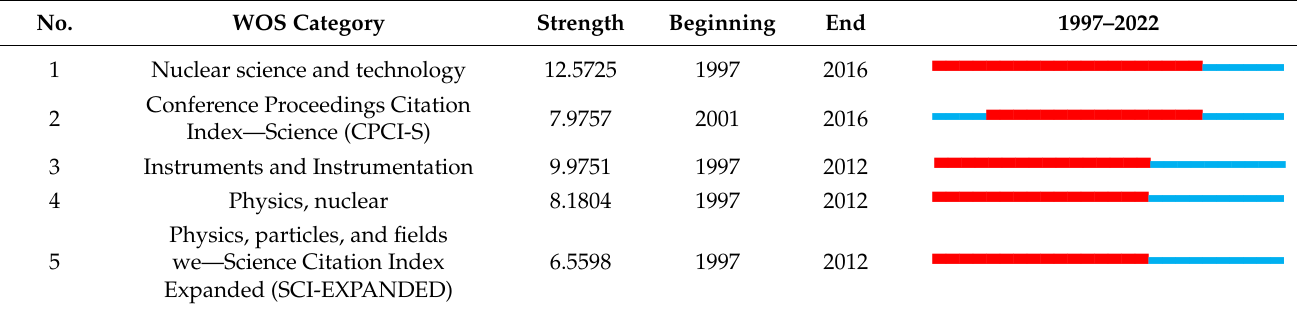
Table 3. Top 5 WOS category nodes according to burst intensity.